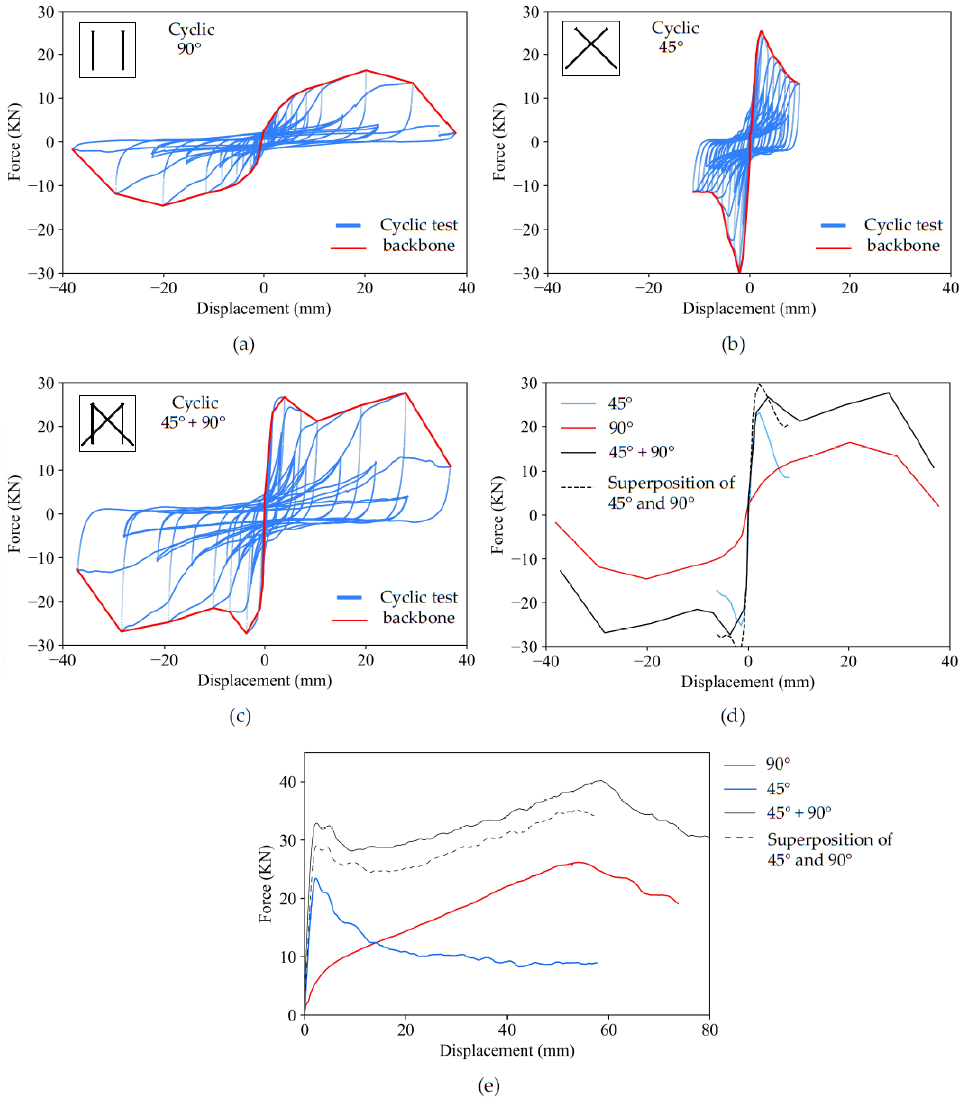
Figure 3. Load-displacement curves for 8 mm STSs (single replicate data): ( a ) 90 ° STS ; ( b ) 45 ° STS ; ( c ) mixed angle STS; ( d ) cyclic backbone curves; ( e ) monotonic curves.